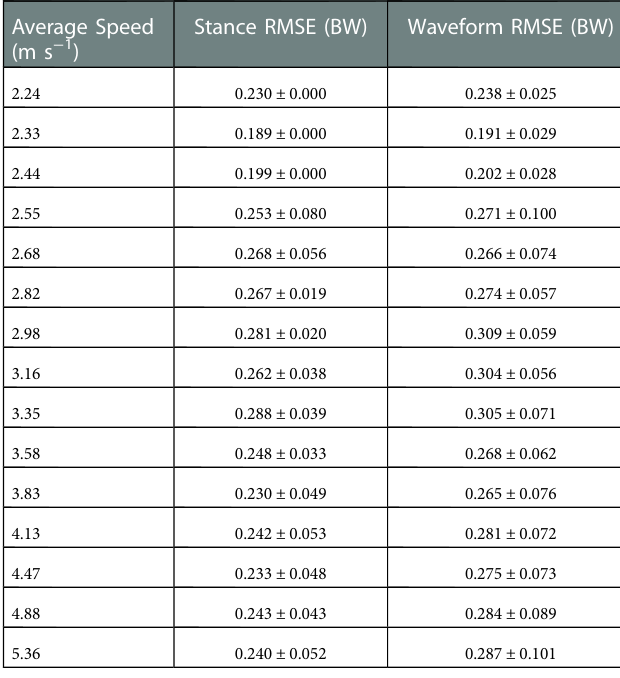
TABLE 3 Stance and waveform root mean square error.